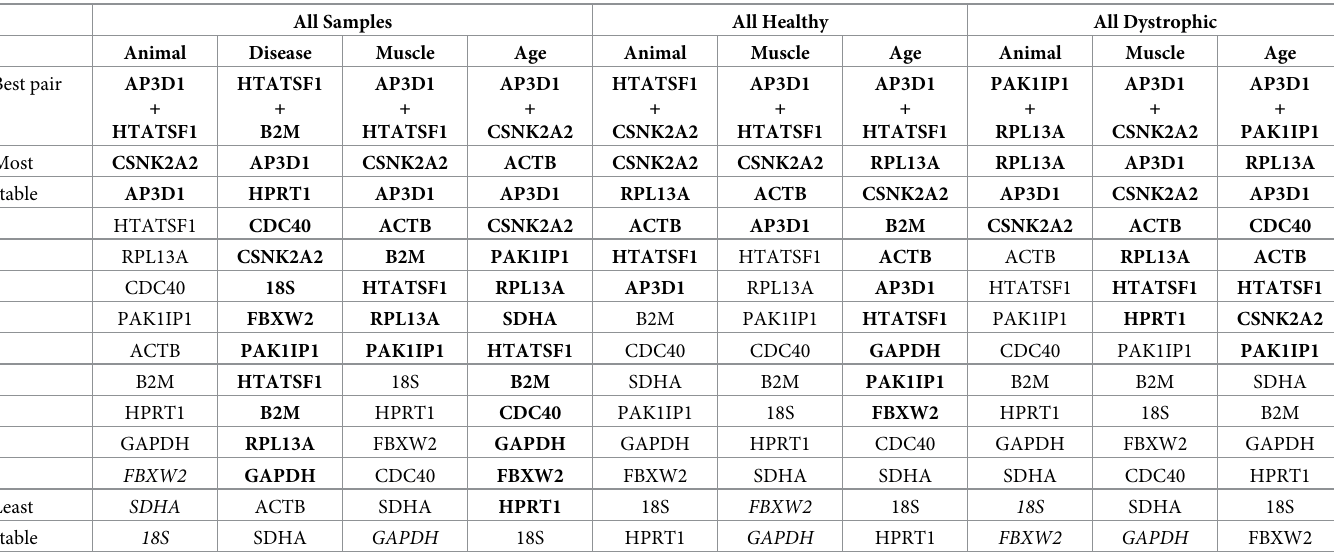
Table 5. Normfinder rankings